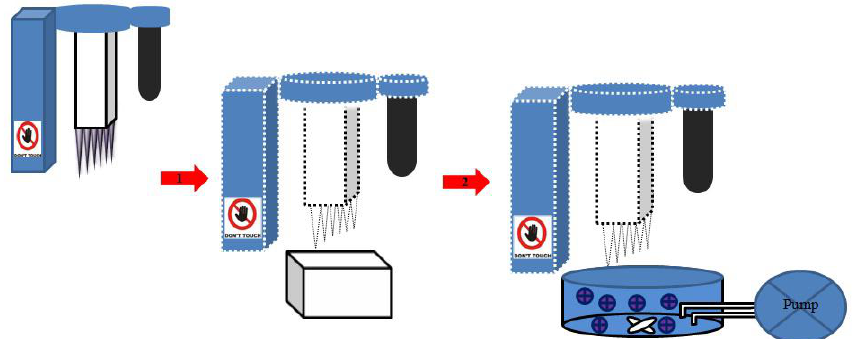
Figure 1. Apparatus used for AG/Ca ++ bead preparation. The robot-operated Eppendorf pipet takes a fraction of AG solutions ( 1 ) and drops them into calcium chloride; ( 2 ) under magnetic stirring. At the end of designed reaction time, the calcium chloride solution is pumped out and a washing solution or a solution containing the second polymer is pumped